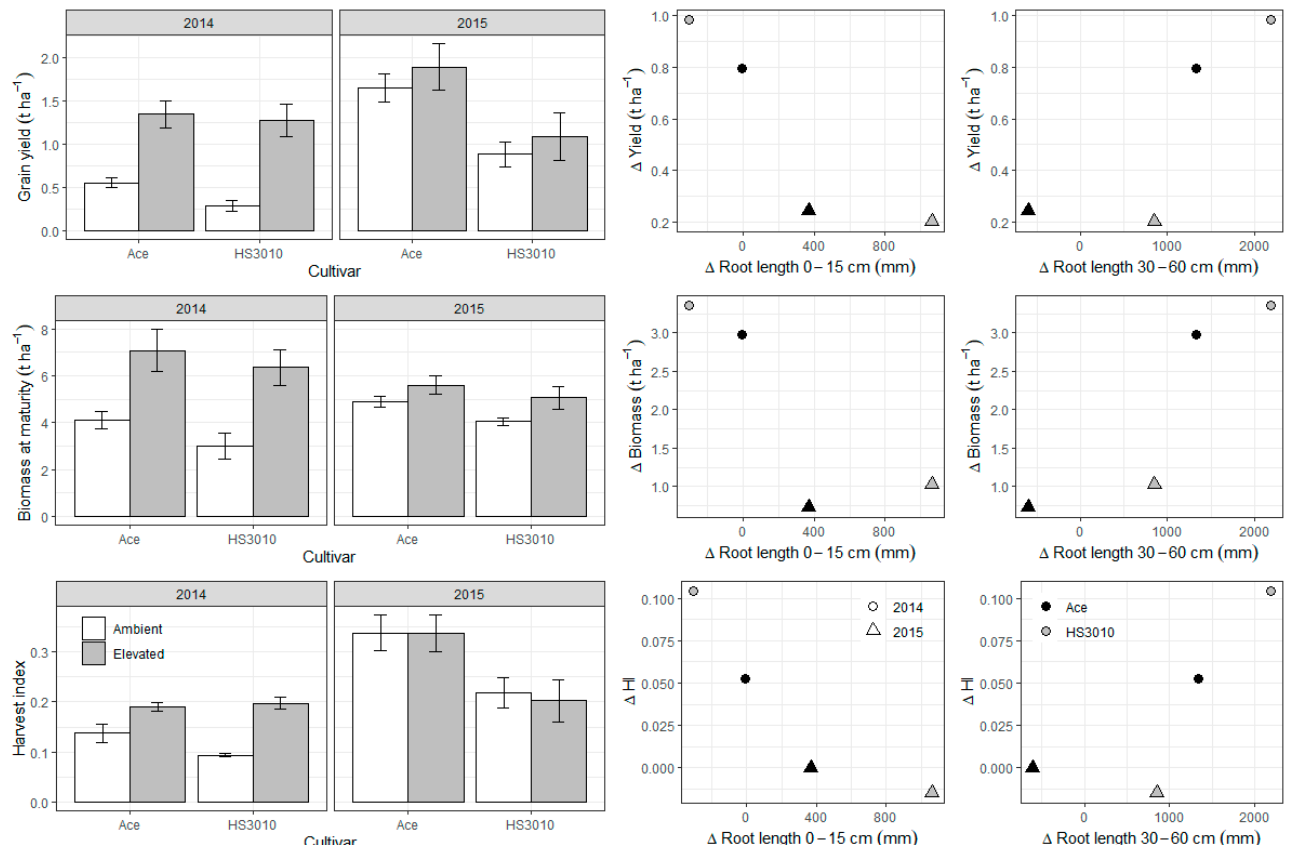
Figure 3. Grain yield, biomass at maturity and harvest index means over CO 2 treatments by years and cultivars in lentil and selected relationships in absolute differences between e[CO 2 ] and a[CO 2 ] in these parameters with increases in root length at 0–15 cm and 30–60 cm at grain fill. Barplots are a re-analysis of the data presented in Bourgault et al. [13].